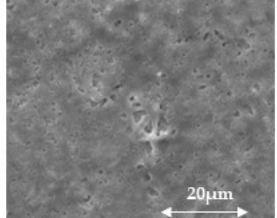
2 /PbO 2 electrode in cross-section.